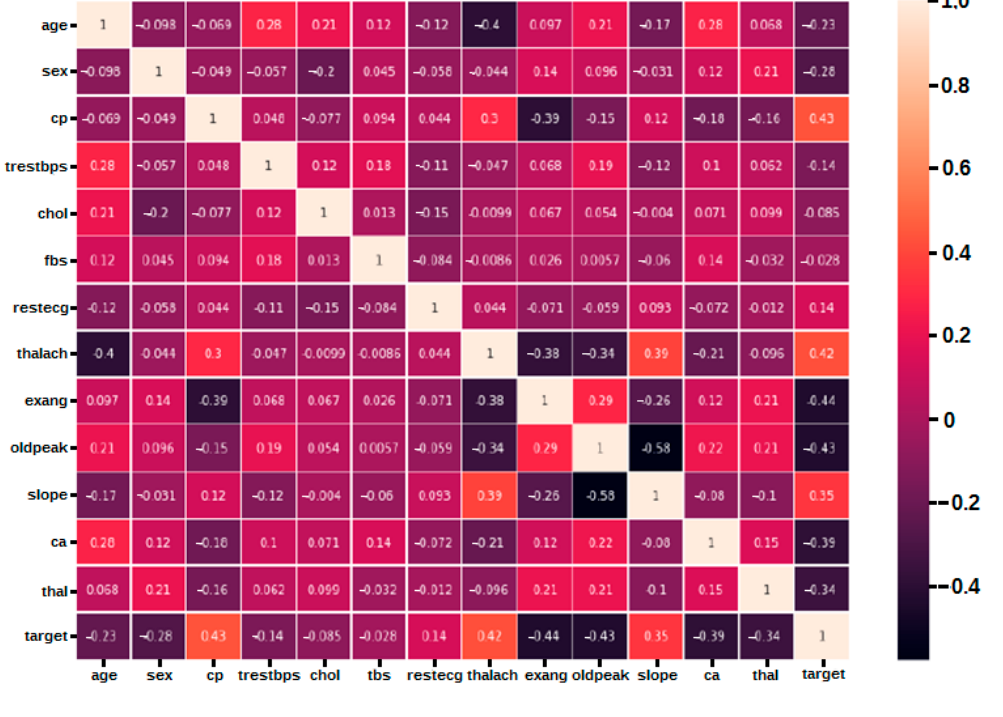
Figure 7. Correlation matrix.